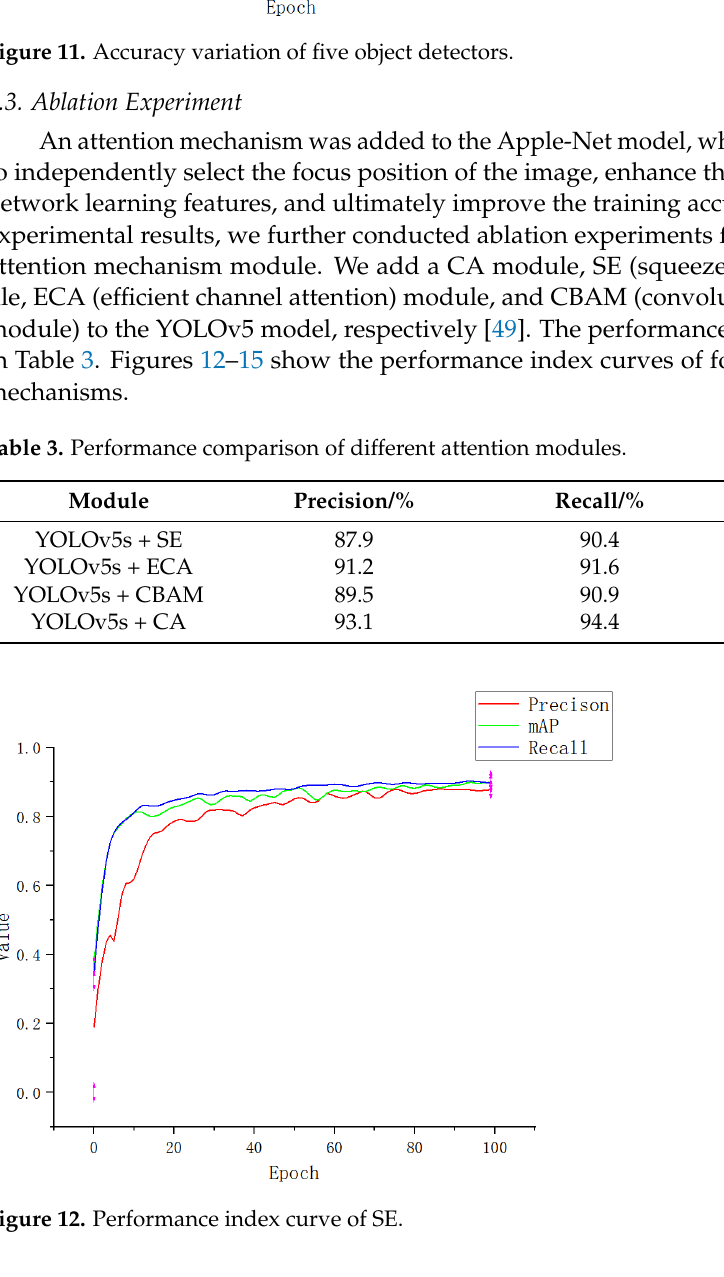
Figure 13. Performance index curve of ECA.